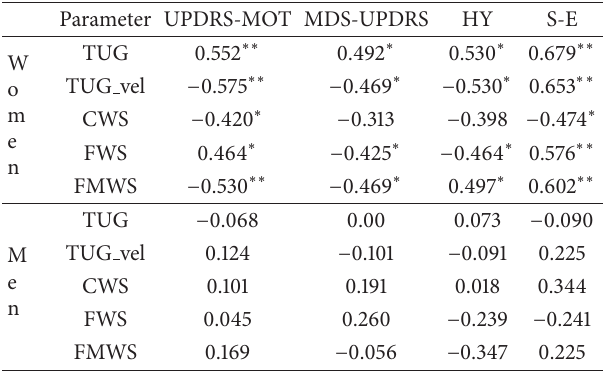
Table3:Associationsbetweenassessedvariablesinwomen( 𝑛 = 14 ) and men ( 𝑛 = 14 ) with